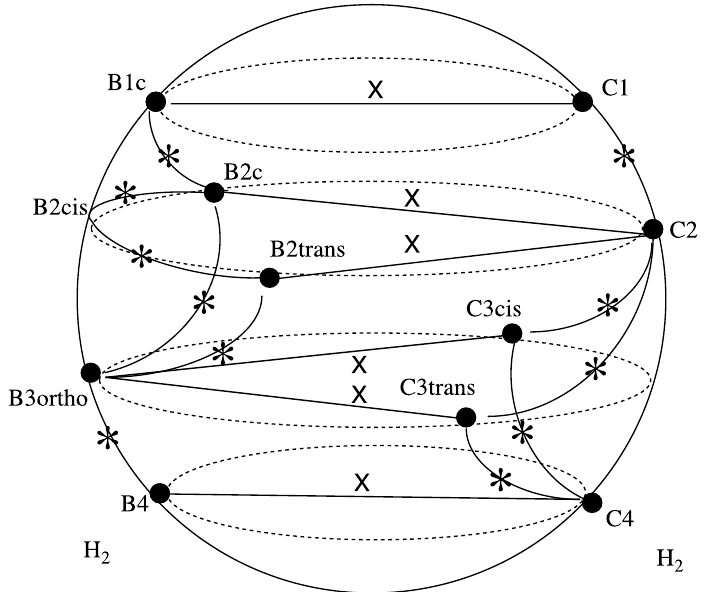
Figure 4. Reaction path network for osmium-catalyzed production of H 2 from OsC 6 H 6 cation. A sphere (outlined by the solid circle) is sliced to define four planes intersecting the sphere as shown by dotted lines. These planes contain species labeled X = B and C with indices 1, 2, 3, and 4 in sequence from top to bottom. The number of H atoms attached to Os are 0, 1, and 2 for X1, X2, and X3; X4 refers to OsC 6 H 4 cation. Interconversions of bicyclic species (BB paths) appear on the left; interconversions of monocyclic species (CC paths) appear on the right. Transition states are each marked with an asterisk *. Interconversions of monocyclic and bicyclic species follow BC paths with transition states marked by X. Table 1. Energetics ( B97XD/def2-tzvp) for landmarks along the B path for H transfer to polycyclic Os species from the most stable species, the C 6v complex of Os cation with benzene, OsC 6 H 6+ . This is called B1 closed . Species labels and Gibbs energies (G) in Hartrees are reported along with relative Gibbs energies, G–G 0, in electron volts (eV). The Gibbs energy for B1 closed is the reference point (0).